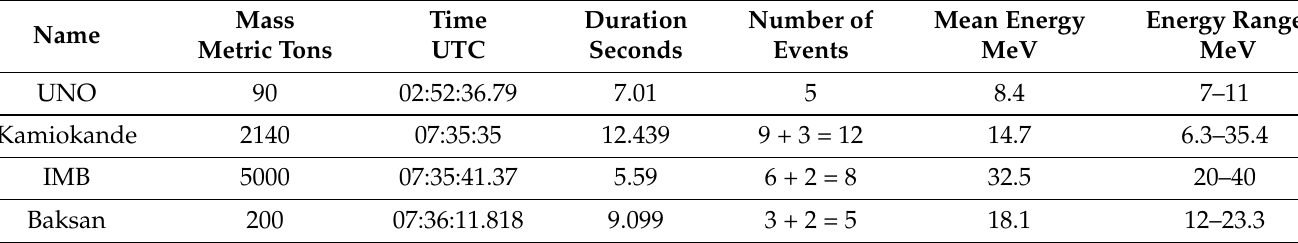
Table 1. Summary of the reported neutrino observations of SN1987A. The mean energy is a simple average of the energy of the reported events. It is not corrected for efficiency. The mean energy gives a rough idea of the portion of the energy spectrum sampled by that detector. The detectors have different capabilities and can only be compared after corrections for inefficiencies and other biases are accounted